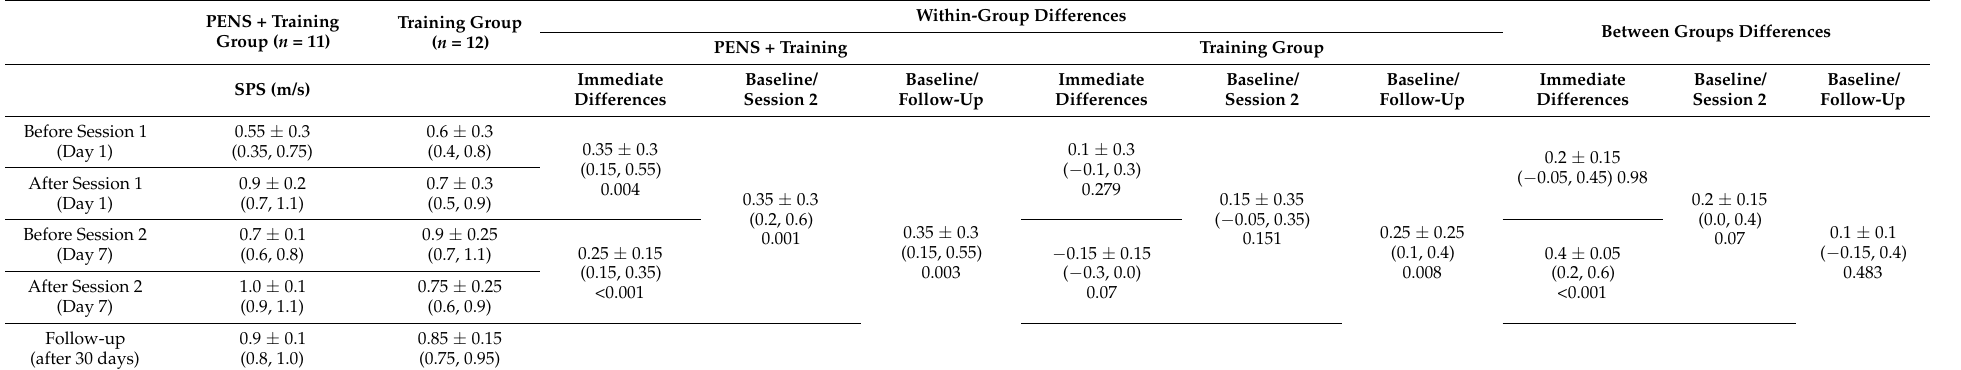
Table 4. Timeline scores, within-group, and between-groups changes in squat performance speed